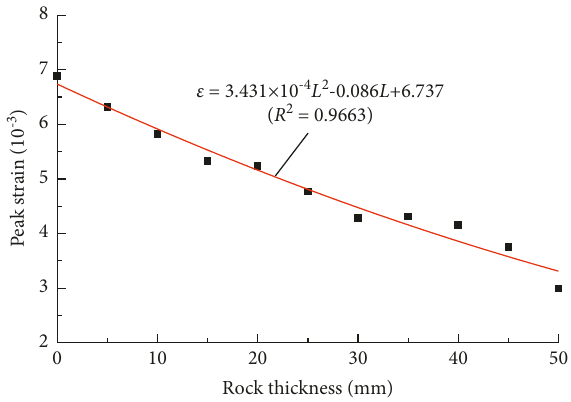
Figure 8: Fitting curve of relationship between rock thickness and peak strain.